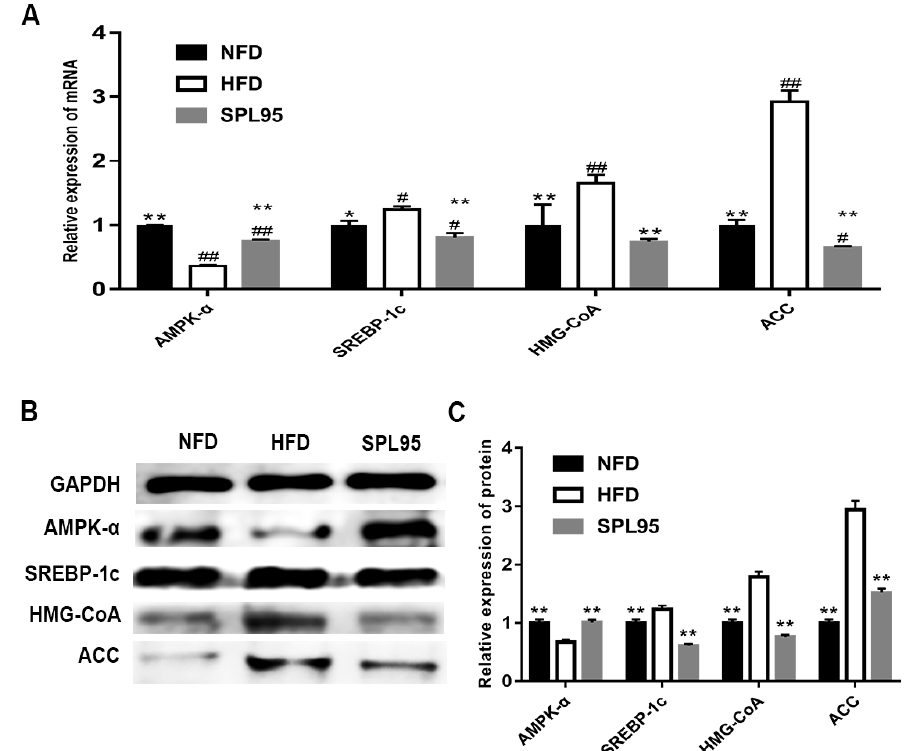
Figure 3. The mRNA and protein expressions levels involved in lipid and glucose metabolism as determined using real-time PCR ( A ) and western blotting ( B , C ). The differences were assessed by ANOVA and denoted as follows: # p < 0.05 and ## p < 0.01 compared with the NFD group; * p < 0.05 and ** p < 0.01 compared with the HFD group.